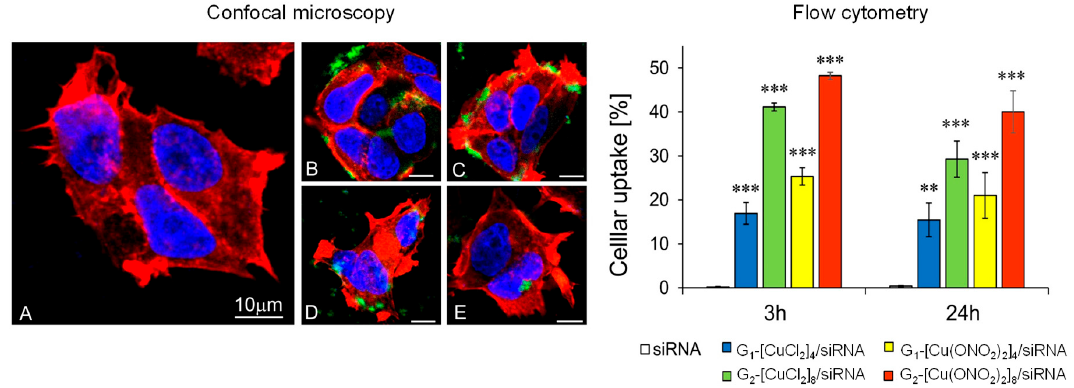
Figure 8. Confocal microscopy: ( A ) naked siRNA, ( B ) G 1- [Cu(ONO 2 ) 2 ] 4 /siRNA ( C ), G 2- [Cu(ONO 2 ) 2 ] 8 /siRNA ( D ) G 1- [CuCl 2 ] 4 /siRNA and ( E ) G 1- [CuCl 2 ] 4 /siRNA and flow cytometry data